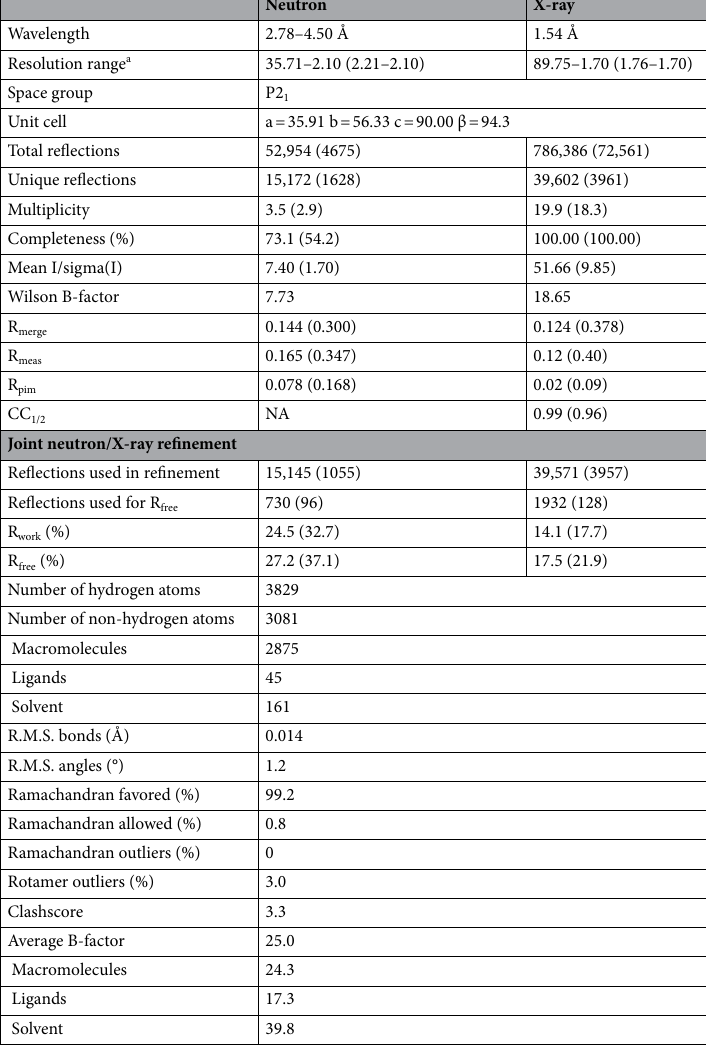
Table 1. Data collection and refinement statistics. a Values in parentheses represent the highest resolution